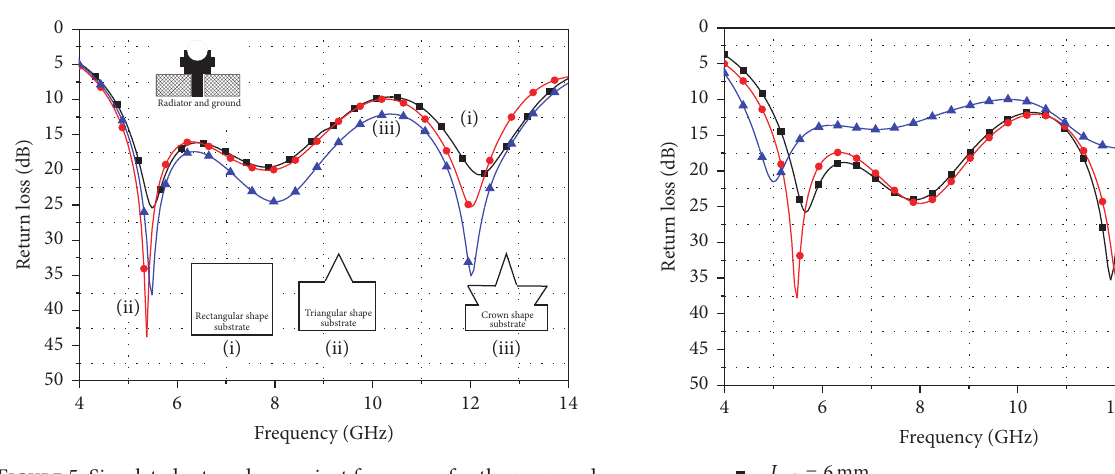
Figure 5: Simulated return loss against frequency for the proposed defected substrate (crown shaped) CPW-fed wideband antenna, defected substrate (triangle shape) CPW-fed antenna, and rectan- gular substrate CPW-fed antenna. Figure 6: Simulated return loss against frequency for the proposed defectedsubstratewidebandantennawithvarious 𝐿 𝑝1 ;otherparam- eters are the same as listed in Table